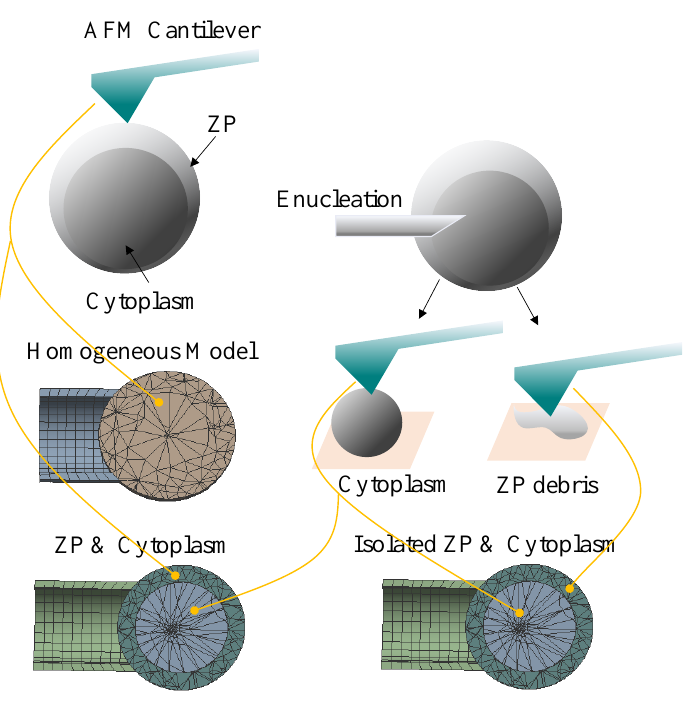
Figure 2. Three viscoelastic FEM models of oocytes that consider the roles of ZP and cytoplasm. The ZP and cytoplasm model has a layered structure mimicking its physical structure observed under a microscope. The ZP layer surrounded the cytoplasmic layer with the two layers bonded (no slip or separation). For comparison purposes, we built the homogeneous model as the whole-cell model and the isolated ZP and cytoplasm model using the mechanical profiling of ZP debris isolated from the oocyte for ZP layer. The viscoelastic properties of the intact ZP and the isolated ZP debris, i.e., shear relaxation modulus and relaxation time, were derived in the AFM indentation and viscoelastic creep test. The same experimental tests were performed to analyze the cytoplasm that was separated from the oocyte through robotic